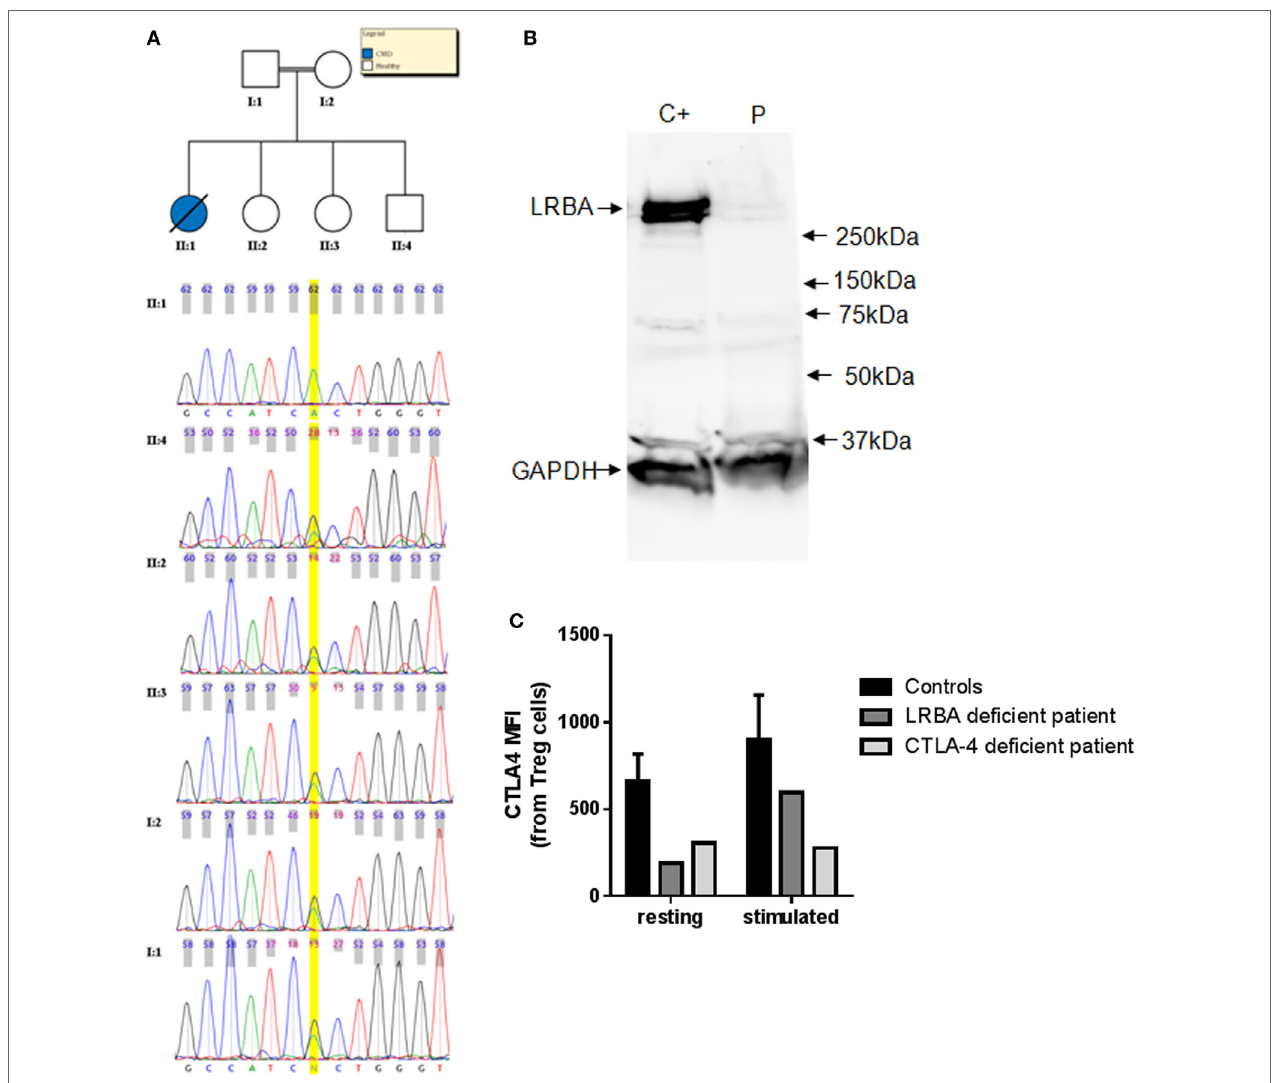
FigUre 1 | (a) Chromatograms corresponding to the Sanger sequencing of the LRBA nonsense mutation region in L283 and five healthy relatives. (B) Western blot analysis of LRBA and GAPDH for L283 patient (P) and a healthy control C + . LRBA protein is not detectable in the LRBA-deficient patient. (c) CTLA4 expression is downregulated in LRBA- and CTLA4-deficient patients. CTLA4 expression was assessed in Treg cells (CD3 + CD4 + CD25hiFoxP3 + cells) in resting and in PHA-stimulated cells (24 h). Bars represent mean values and error bars represent SE of the mean values for adult healthy controls ( n = 5).